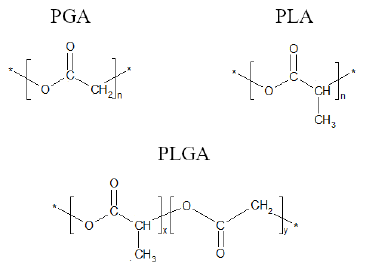
Figure 1. Chemical structures of poly(glycolic acid) (PGA), poly(lactic acid) (PLA), and poly(lactide- co-glycolide) (PLGA). (n: number of repeat units in PLA and PGA; x and y: number of lactic and glycolic units in PLGA, respectively). * another unit of PGA/PLA